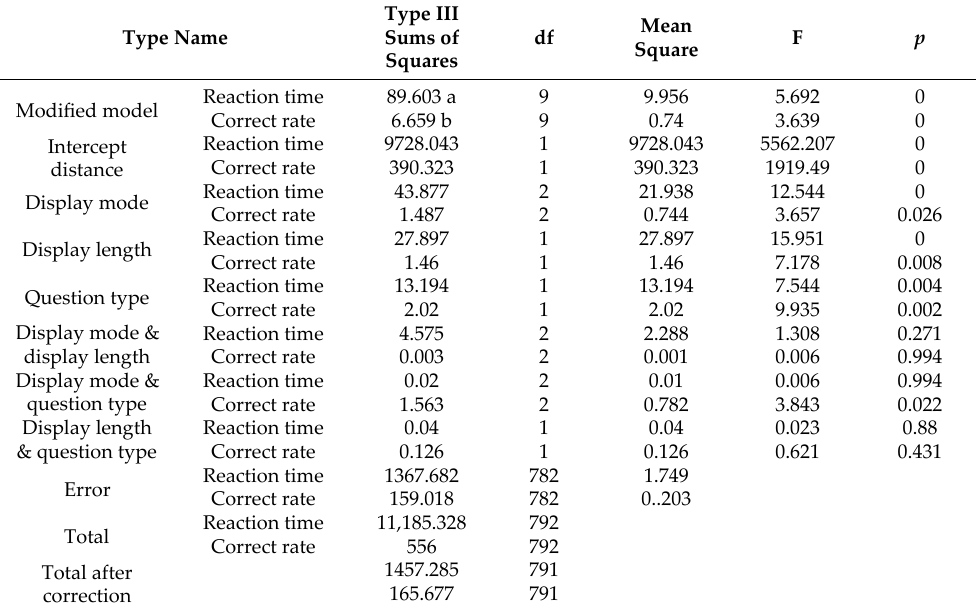
Table 3. ANOVA data main effect and interaction effect tests for response time and correctness.